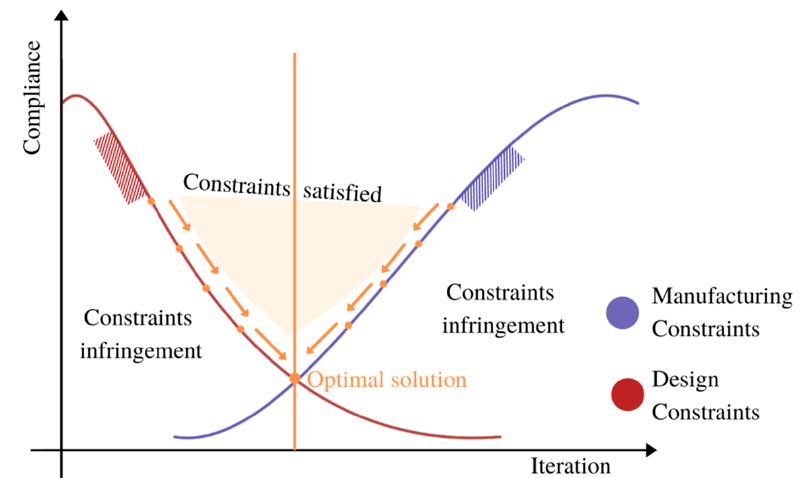
Figure 3. Multiple constraints model example of MMA.